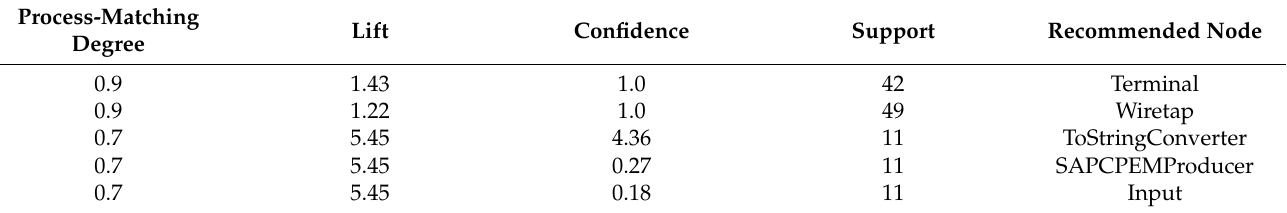
Table 2. Recommended results of real data